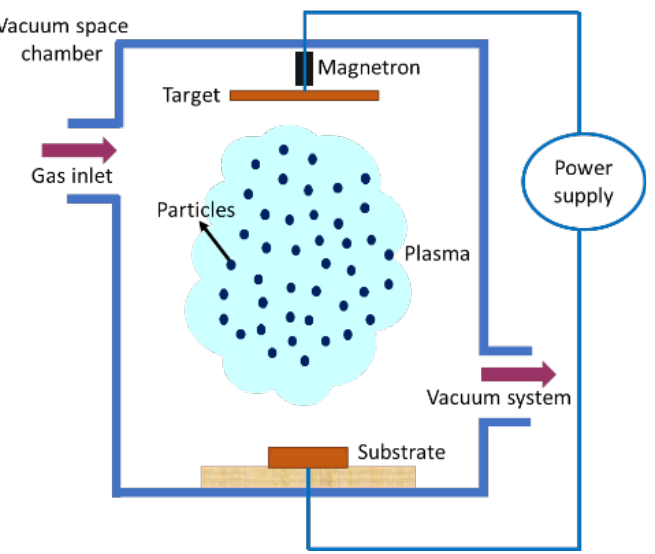
Figure 17. Schematic representation of magnetron sputtering process.